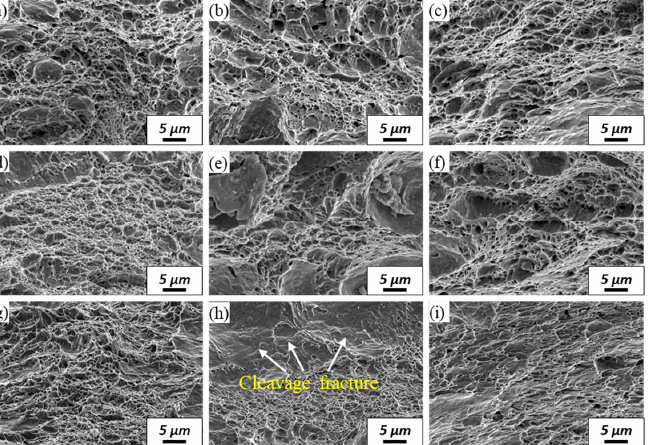
Figure 7. Fractography in the fibrillar region of the low-temperature impact specimens with dif- ferent quenching and tempering processes: ( a ) Q850 °C + T580 °C, ( b ) Q850 °C + T620 °C, ( c ) Q850 °C + T660 °C, ( d ) Q900 °C + T580 °C, ( e ) Q900 °C + T620 °C, ( f ) Q900 °C + T660 °C, ( g ) Q930 °C + T580 °C, ( h ) Q930 °C + T620 °C and ( i ) Q930 °C + T660